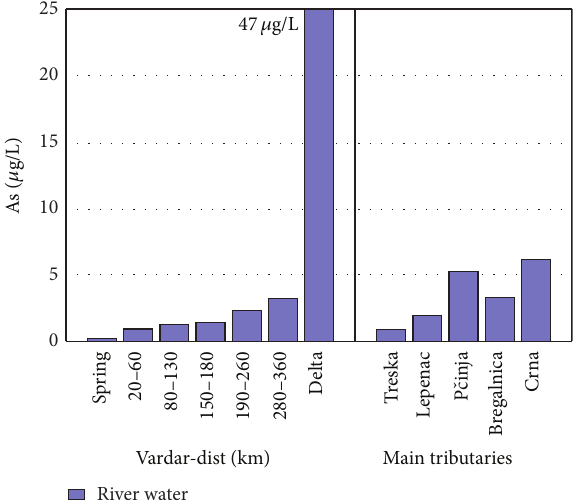
Figure 3: Concentration of As found in river Vardar and main tributaries.